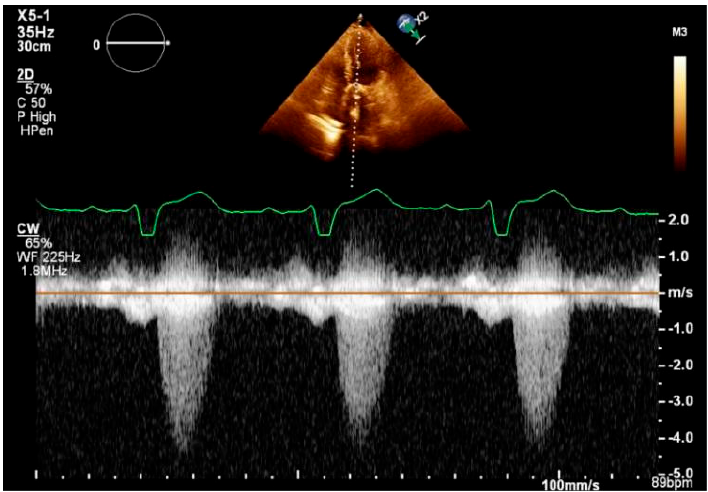
Figure 1. TTE showing peak aortic valve velocity .